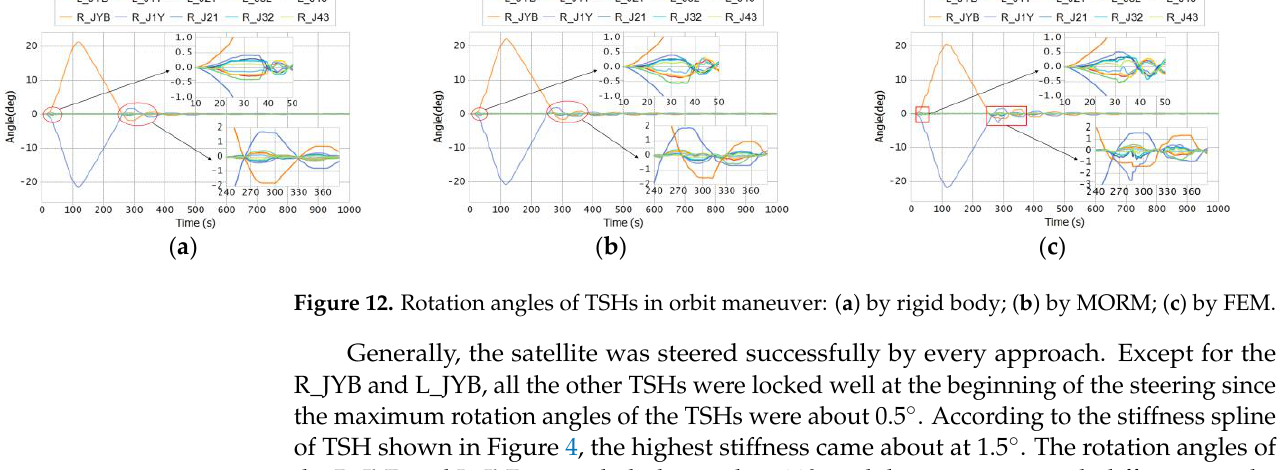
Figure 11. Time history of rotation angle in orbit steering [36]. The rotation angles of TSHs, panel accelerations and stress contour of panels are studied herein, and Figure 12 illustrates the rotation angles of the TSHs in orbit steering by rigid body, MORM and FEM, respectively.